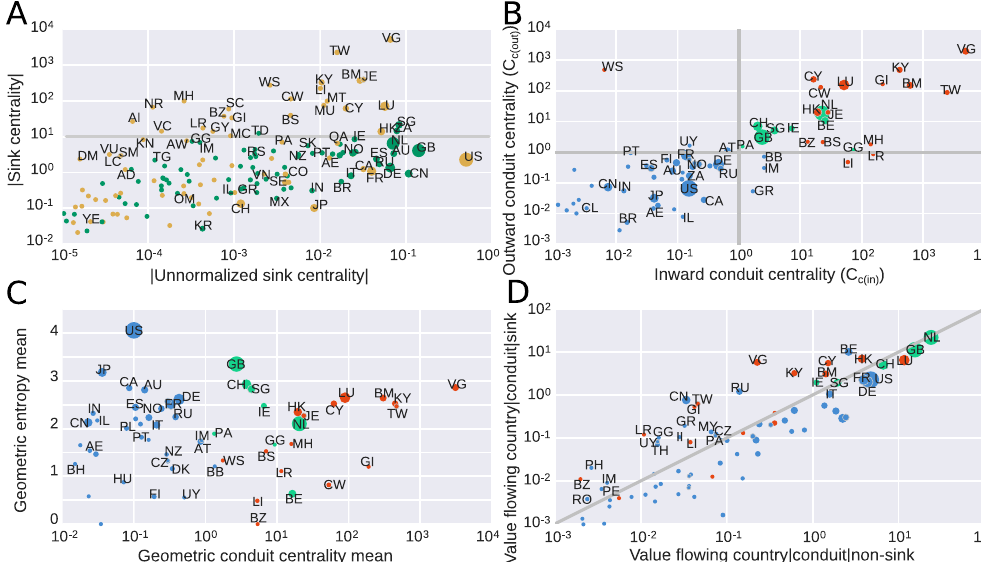
Figure 2. Sink and conduit centralities. ( A ) Absolute value of the sink-OFC centrality versus absolute value of the sink-OFC centrality without the GDP normalization. The color of the node indicates the sign of the sink- OFC centrality (green are negative, orange are positive). The size of the node is proportional to the sum of the value entering and leaving the country. ( B ) Inward vs outward conduit centrality. ( C ) Average conduit centrality (in and out) versus average entropy of the distribution of value (in and out). ( D ) Value flowing through the conduit to non-sink-OFC countries versus non-normalized conduit centrality (value flowing through the conduit to sink-OFC countries). Color in plots B–D indicates function; sink-OFCs are colored in red, conduit- OFCs are colored in green, and all other countries are colored in